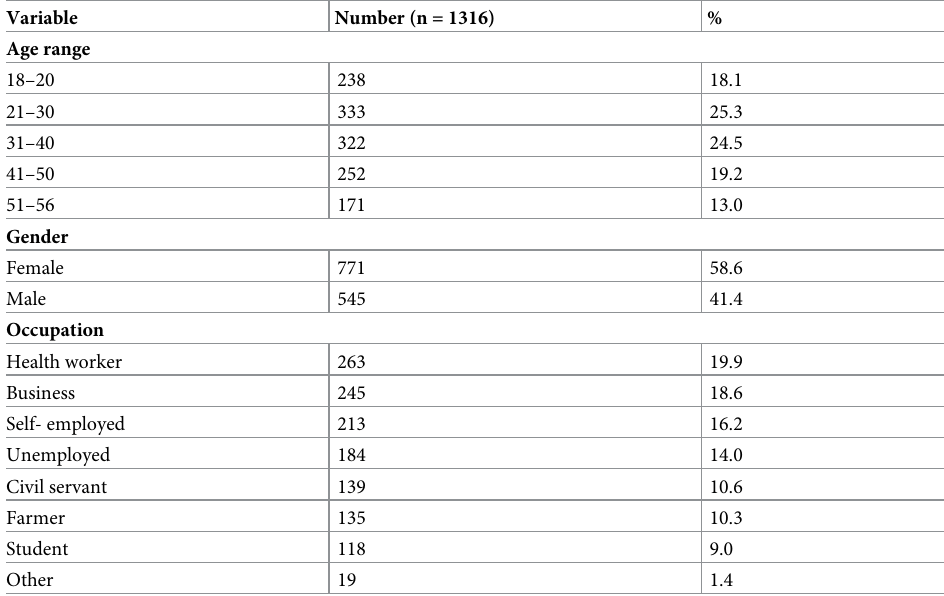
Table 1. Sociodemographic data of